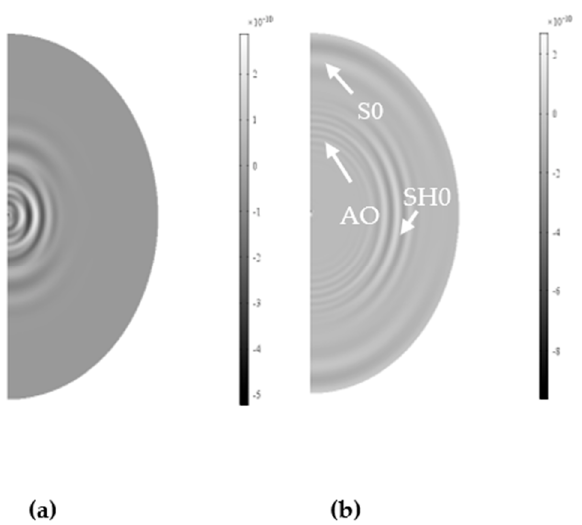
Figure 8. Surface in-plane displacement plot at 50 μ s ( a ) on right; at 100 μ s ( b ) on left for Configuration A. Modes are identified and labeled accordingly.